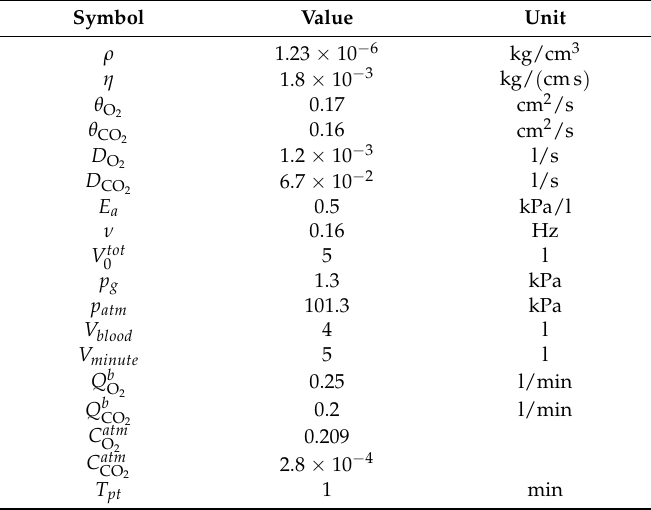
Table A1. Constants of the model.